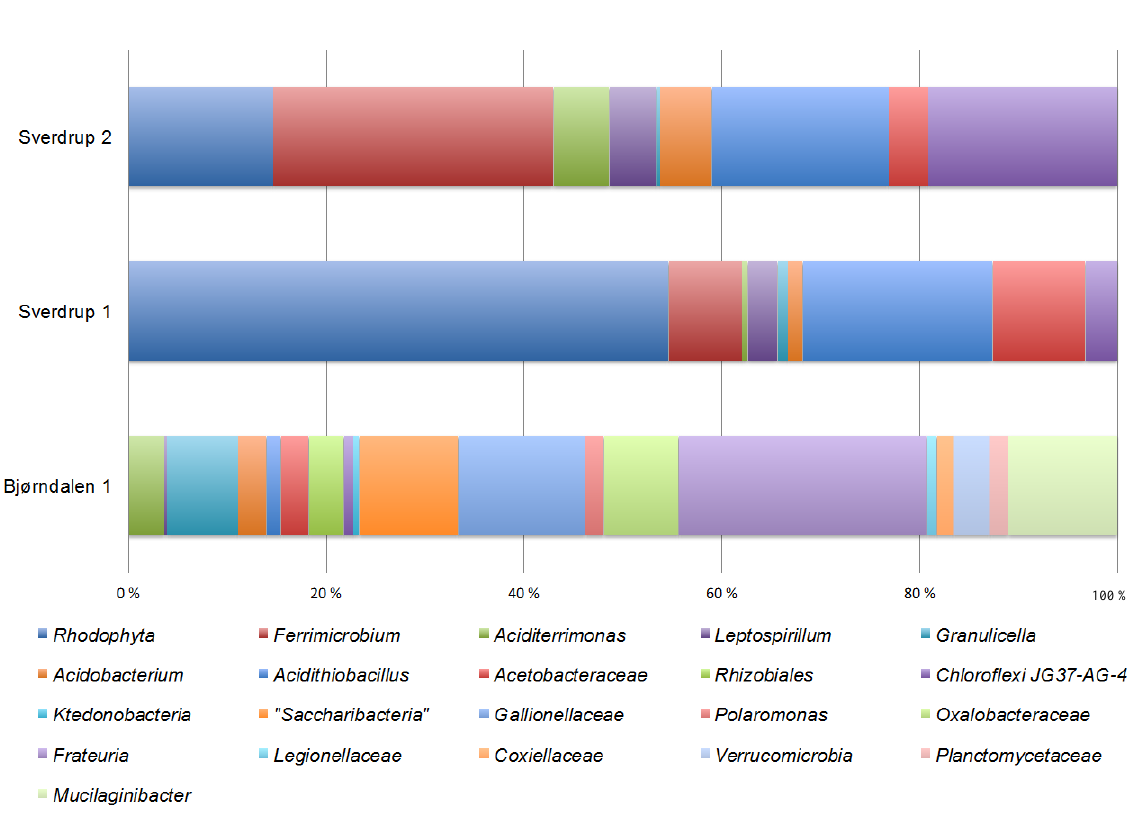
Figure 2. Microbial community composition on the different samples from acid mine drainage at Bjørndalen and Sverdrup areas. The figure shows the percentage of classified reads from the tagged amplicon library for each